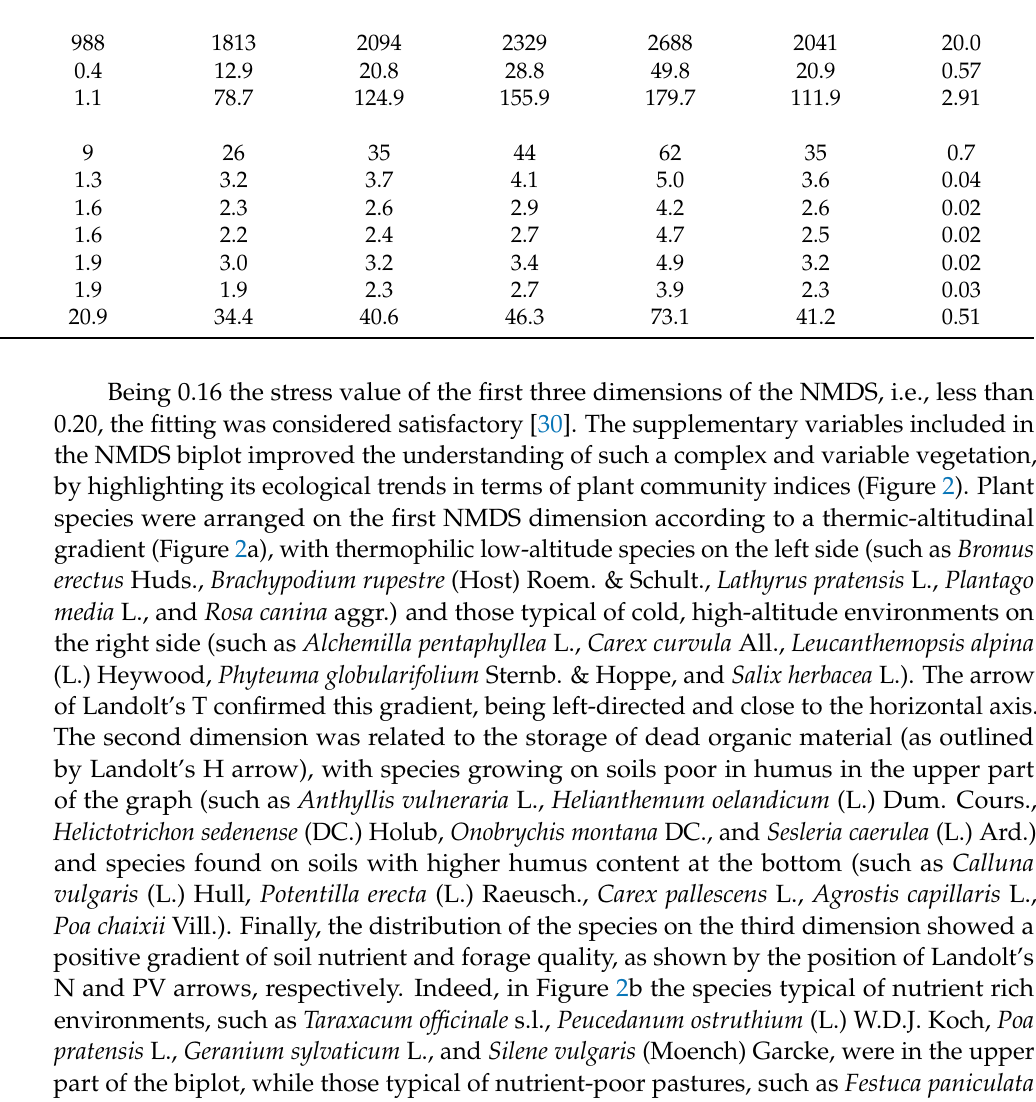
Table 1. Climatic, topographic, and vegetation descriptors of the 324 sites. SE, standard error of the mean; Landolt’s indicators: F, soil moisture; N, soil nutrients; H, humus; T, temperature. Variable Min 25%